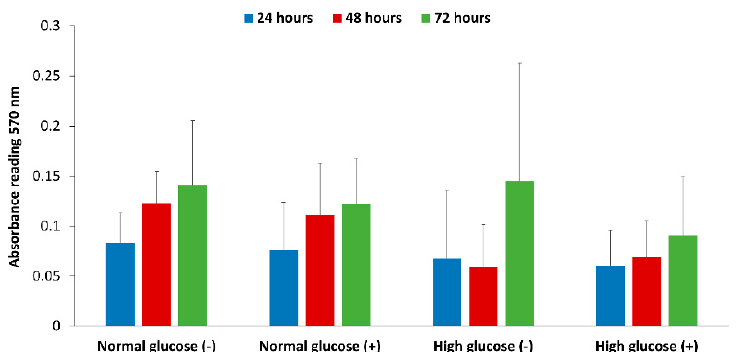
Figure 6. The rate of proliferation observed in HDFa cultured in normal (5.5 mM) and high glucose (25 mM) conditions with (+) and without ( − ) stimulation from 24 to 72 h. Three independent experiments were performed in triplicates ( n = 3). p value < 0.05 was considered statistically significant.